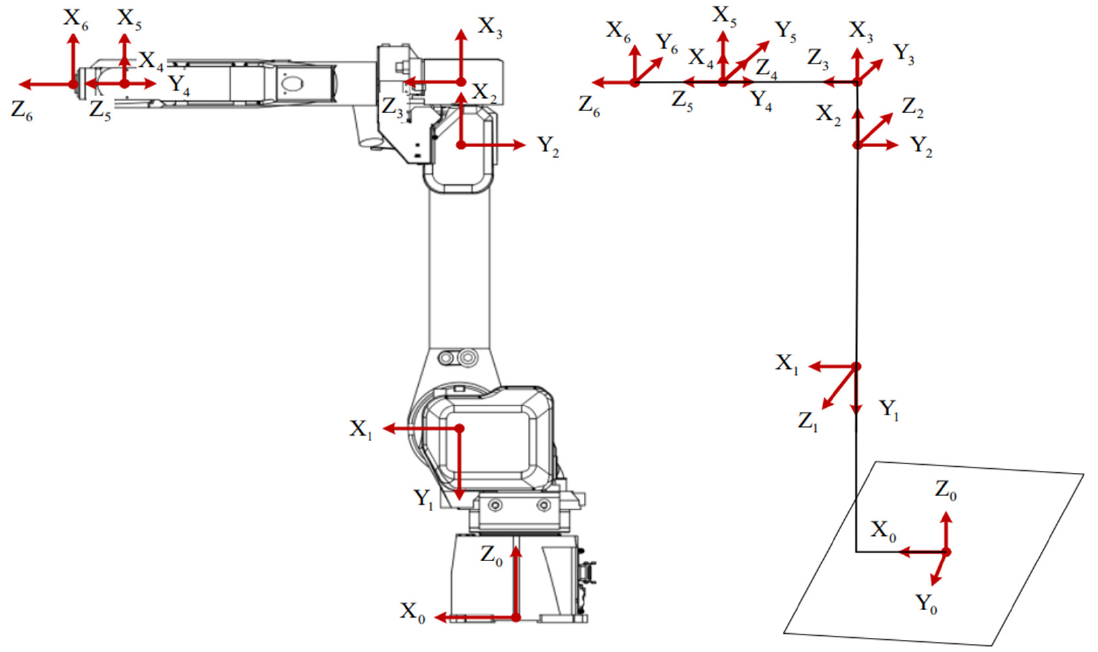
Figure 9. Simplified diagram of the D-H linkage coordinate system of the robot.